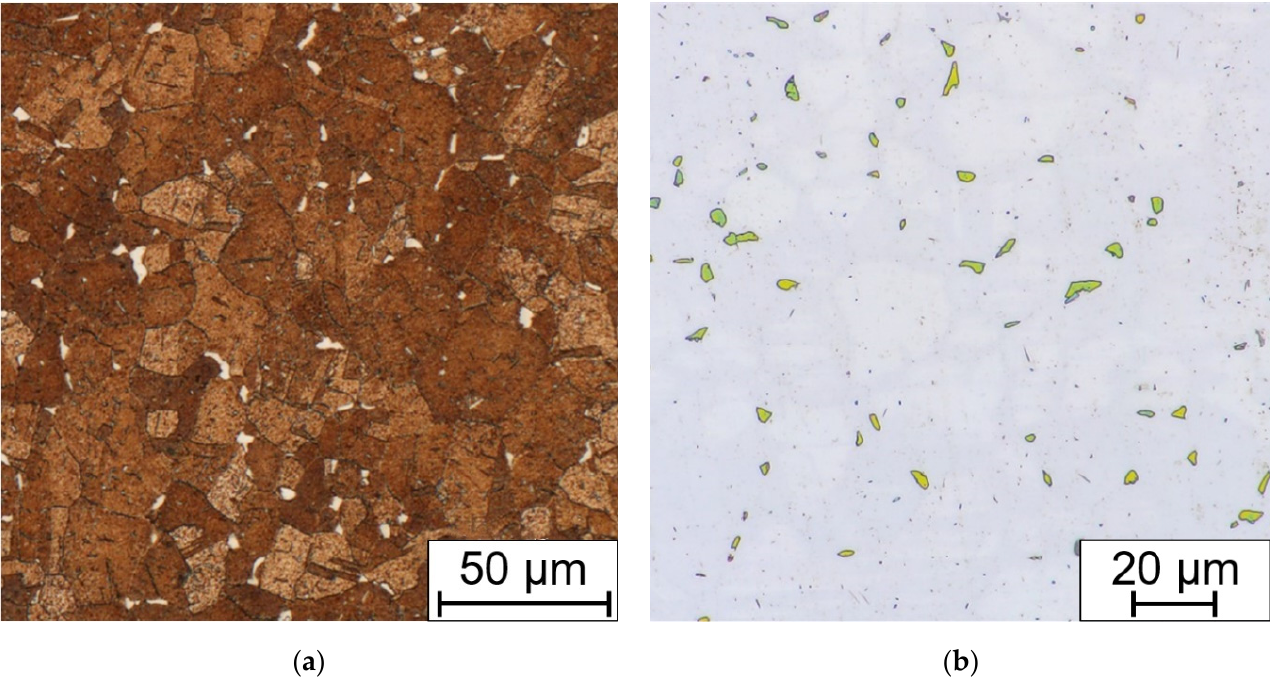
Figure 11. Comparison of ( a ) Beraha II immersion etched and ( b ) electrolytic NaOH etched (1.5 V DC, 1 s) bend sample without HT, after 7,560 h at 650 °C.